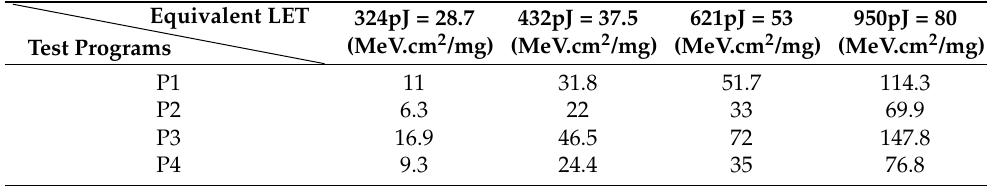
Table 2. Laser SEE soft error cross section of Training set (10 − 7 errors/cm 2